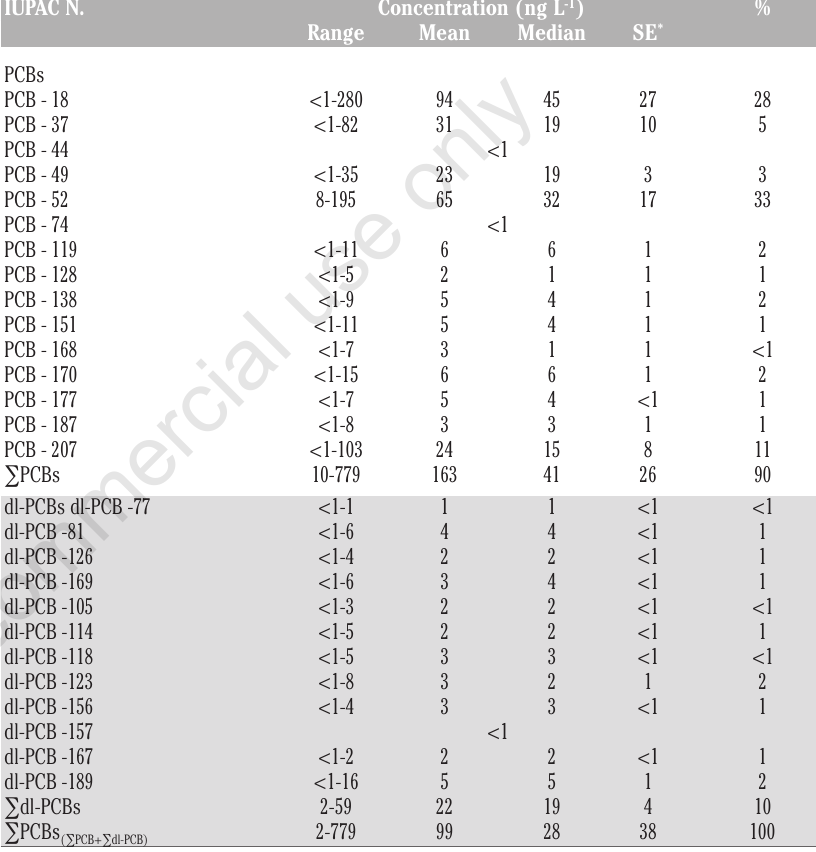
Table 1. Concentration of polychlorinated biphenyl congeners in Yamuna River water from Delhi, India. IUPAC N.